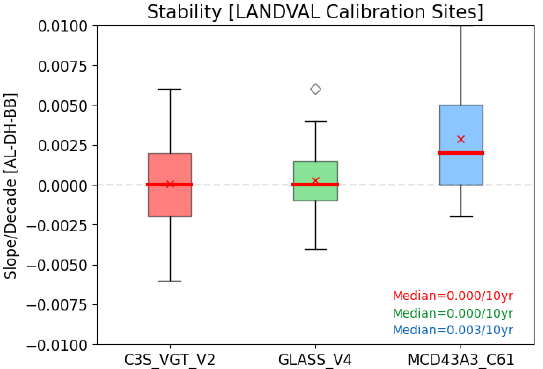
Figure 14. Box plots of the slope per decade (2001–2010) for C3S V2 (red), GLASS V4 (green) and MCD43A3 C6.1 (blue) for black-sky albedos where each box stretches from the 25th percentile to the 75th percentile of the data and whiskers include 99.3% of the coverage data ( ± 2.7 σ ). Ouliers are represented by rhombus. Red lines/crosses represent median/mean values. Computation over desert calibration sites.